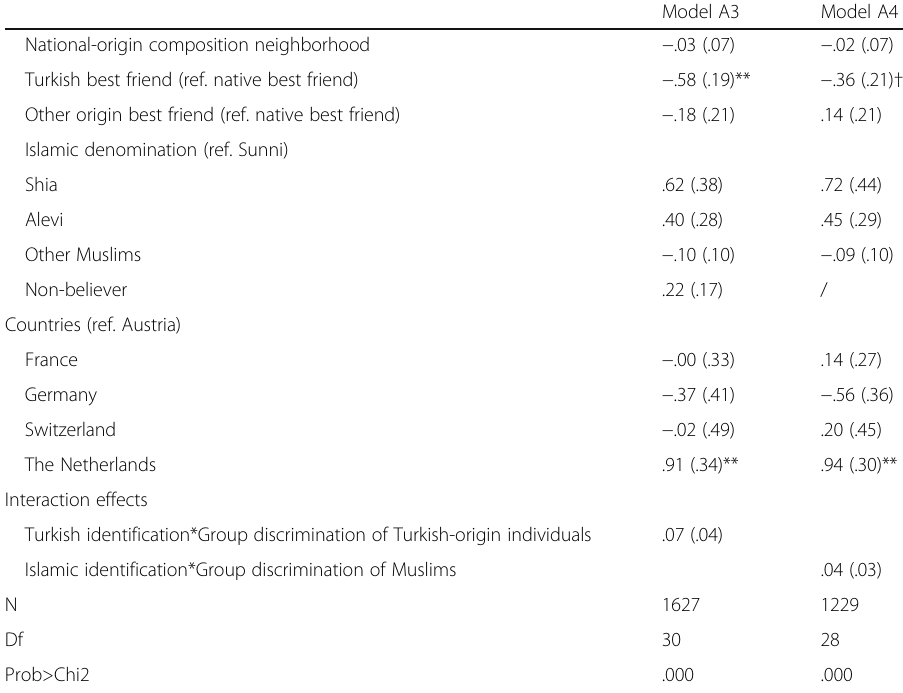
Table 10 Binary logistic regression: Interplay between social identifications, group discrimination and local voting probability (Continued)